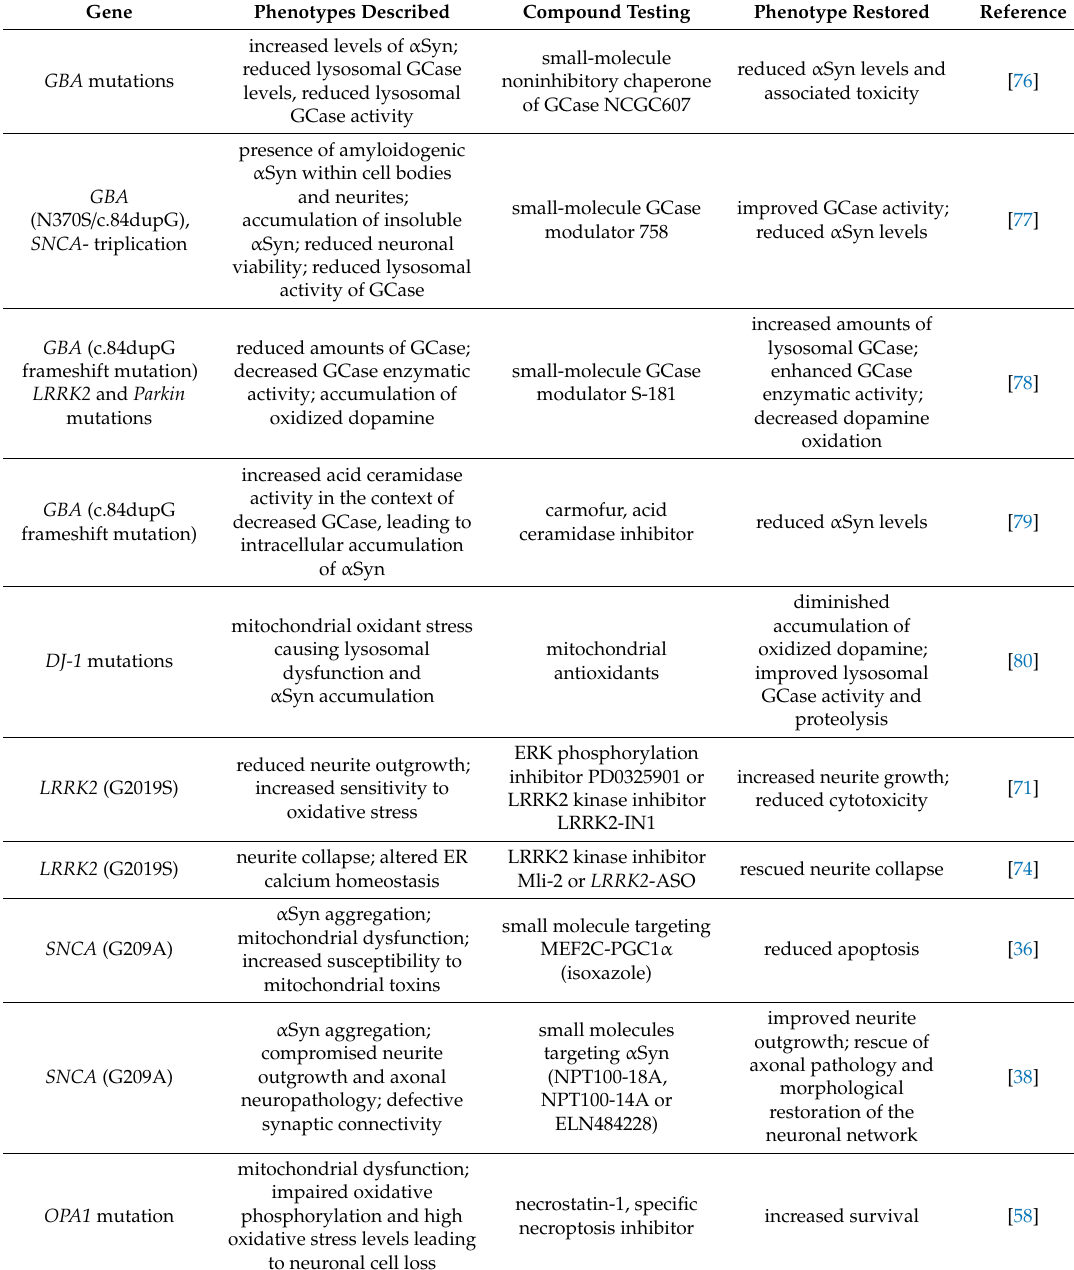
Table 2. Summary of hiPSC-based models of PD that have been used for drug testing. This table briefly describes the rescue of disease-related phenotypes in PD hiPSC-derived neurons by selected